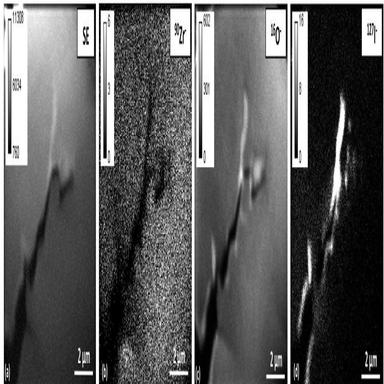
Summed NanoSIMS maps of the crack tip region from mandrel tested irradiated Zircaloy-2. Approximate region of analysis is highlighted in (a). Each image is individually scaled (counts) as indicated by the colour scale on each image.